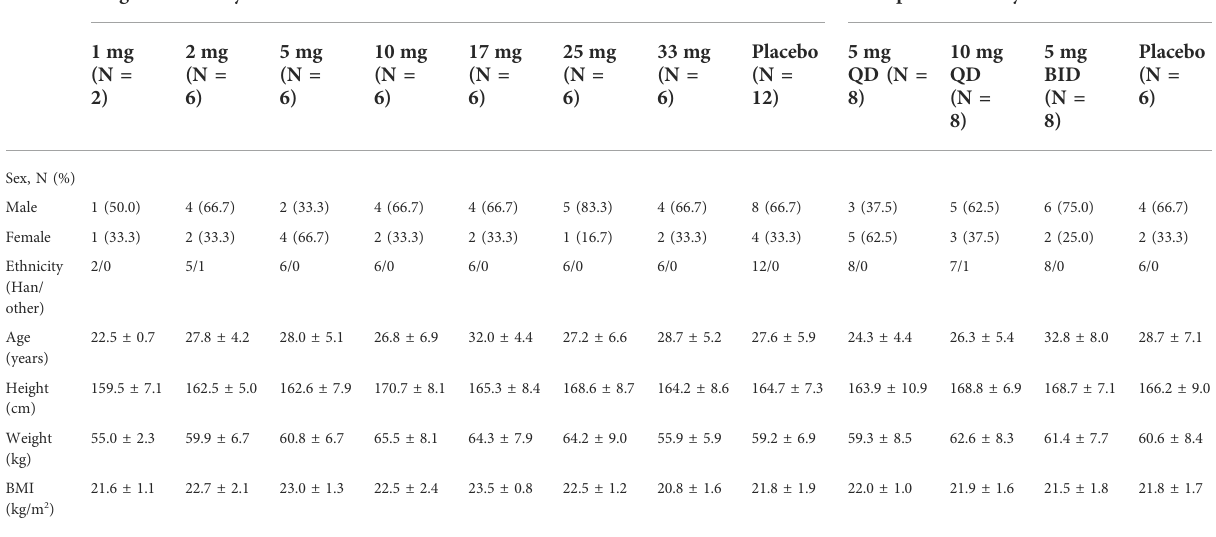
TABLE 1 Demographics and baseline characteristics of subjects. Single-dose study Multiple-dose study